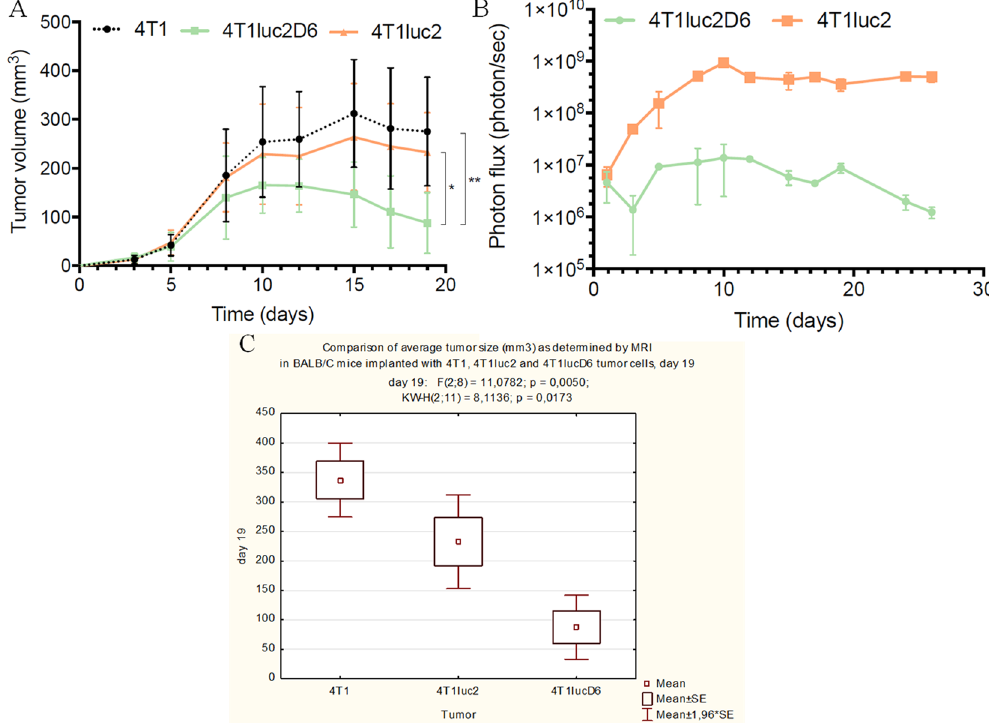
Figure 2. Growth in BALB/c mice (n = 5–6 per group) of primary tumors induced by the implantation of 4T1, 4T1luc2 and 4T1lucD6 cells (see Methods for description). Growth curves obtained by MRI visualize average tumor volume in cubic mm, with STDV ( A ); Growth of primary tumors induced by implantation of 4T1luc2 and 4T1lucD6 cells monitored by bioluminescent imaging; curves depict an average photon flux from the tumor per sec, with STDV ( B ); Statistical comparison of the tumor sizes evaluated by MRI ( C ). Median size of 4T1lucD6 tumors is significantly lower (p = 0,017), and of 4T1luc2 tumors tend to be lower than of 4T1 tumors, although the difference is not significant (p = 0,17). Day of implantation is counted as day 0. Statistical comparisons are done using Kruskal Wallis and Mann-Whitney tests (Statistica AXA